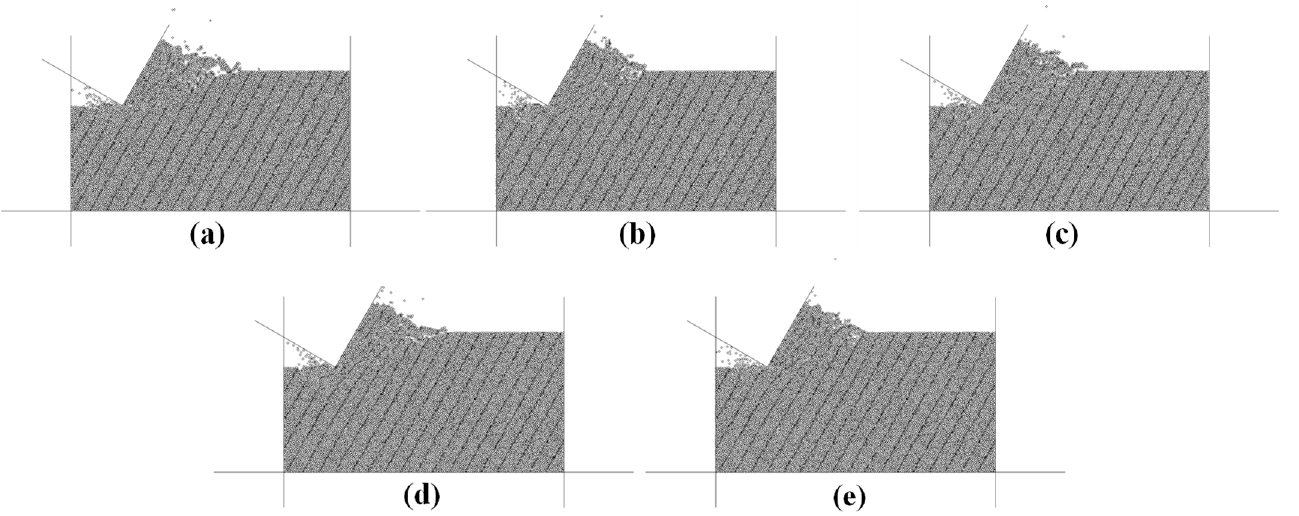
Figure 18. Cutting failure of numerical specimens with different cutting rates. ( a ) 6 m/s; ( b ) 7 m/s; ( c ) 8 m/s; ( d ) 9 m/s; ( e ) 10 m/s.